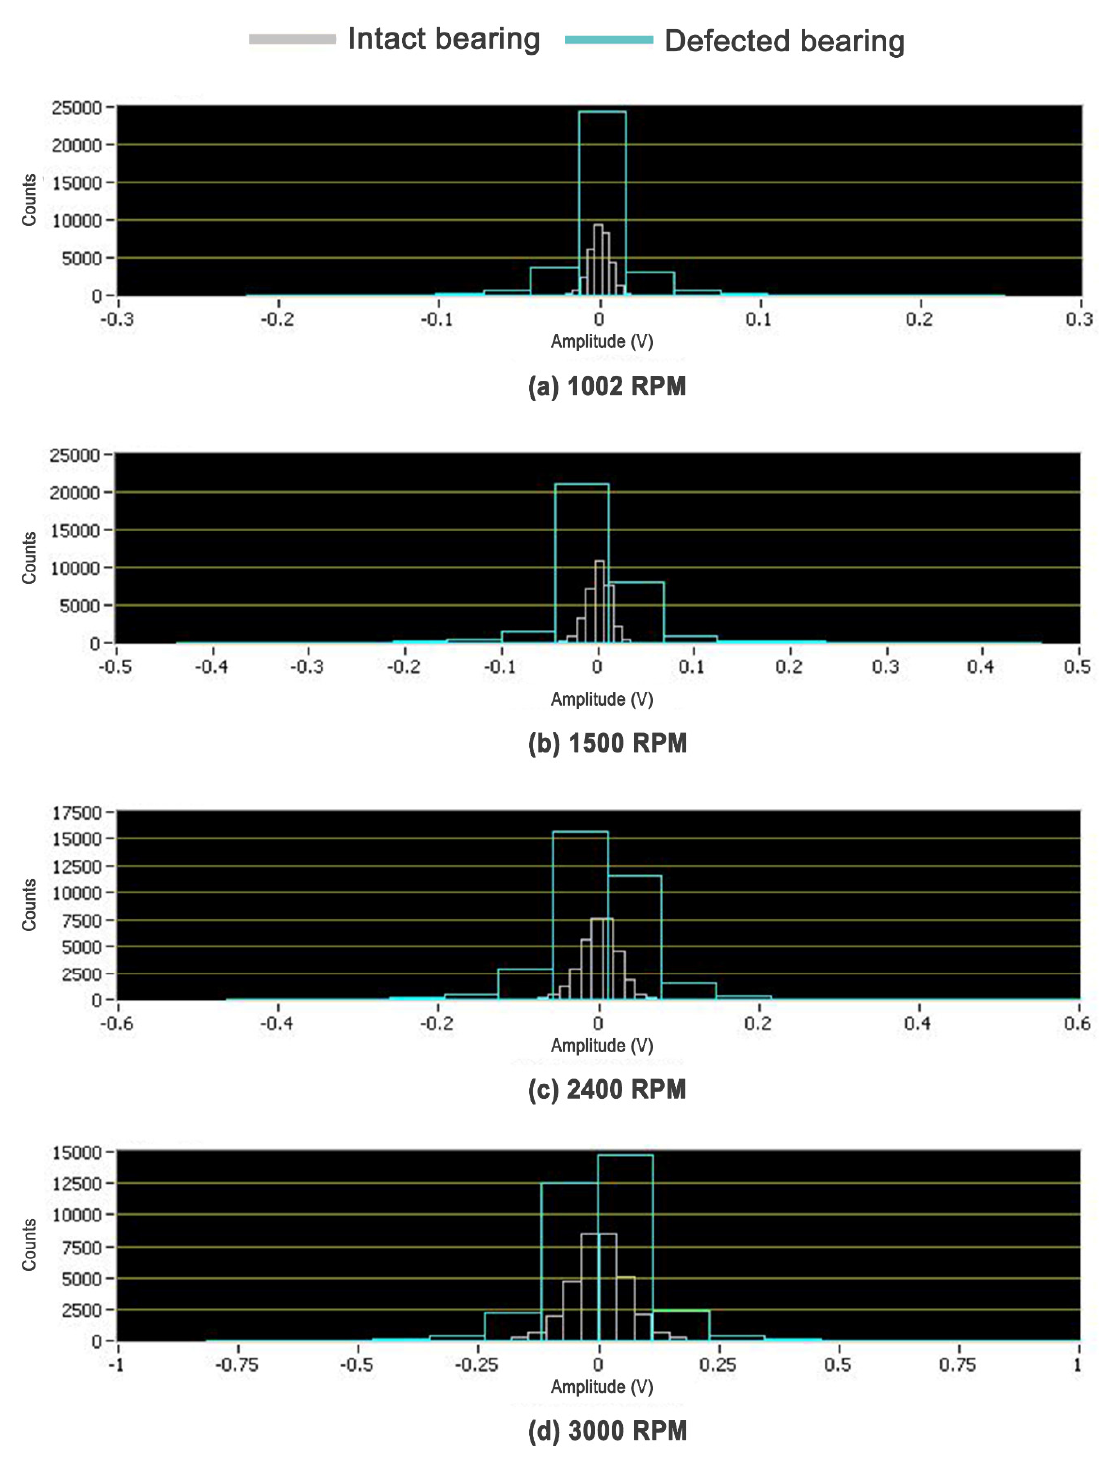
Figure 9. Histograms for a combination of damage with installing a bearing loader.